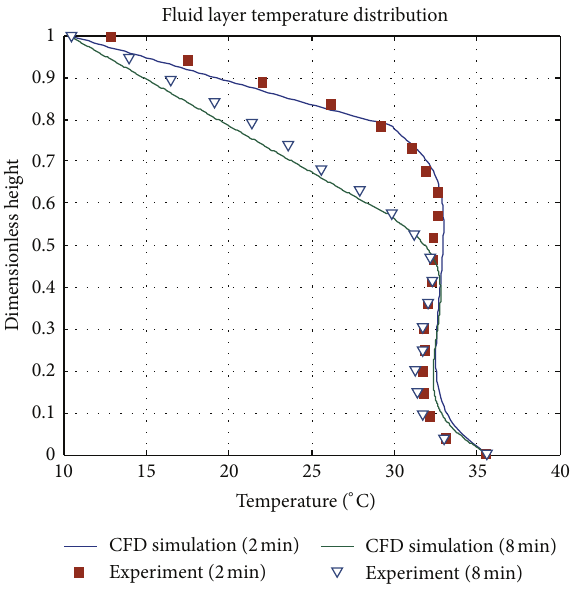
Figure 8: CFD and experimental temperature profiles across the fluid layer.